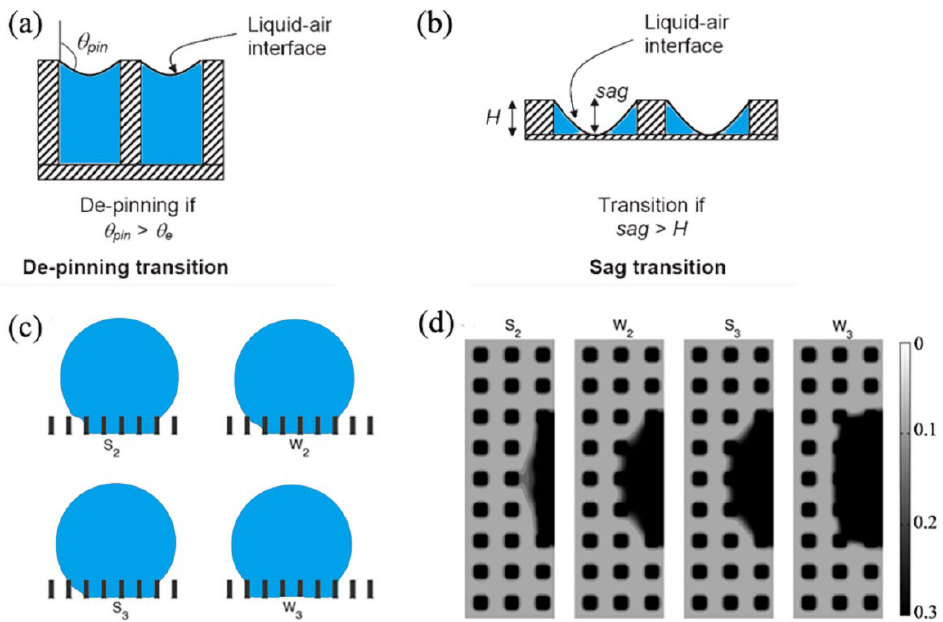
Figure 4. The schematic diagram of the droplet longitudinal propagation in flat-top pillar microstructure for ( a ) depinning transition, and ( b ) sag transition. Reprinted with permission from Ref. [66]. Copyright@2004, Langmuir. ( c ) The schematic diagram of droplet lateral propagation, and ( d ) the simulation results. Reprinted with permission from Ref. [72]. Copyright@2014, Langmuir.